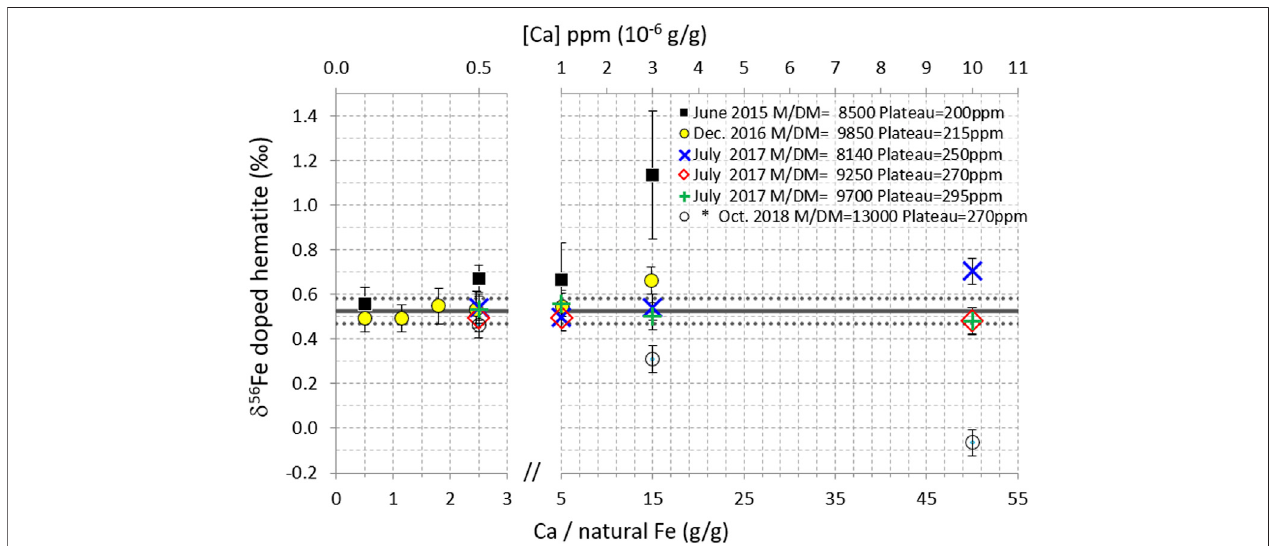
FIGURE 5 | δ 56 Fe of hematite (200 ppb natural Fe) doped with variable amounts of Ca, for fi ve measurement sessions on the Neptune and (*) one session on the Neptune Plus (2018). Data points are the averages of replicate measurements ( n (cid:1) 2 – 5), except for 2017 data (no replicate). Error bars are 2 standard deviations of the replicate measurements for the 2015 – 16 data and the long-term internal precision (2SD) of the instrument (0.06 ‰ ) for the 2017 data (no replicate) and for the 2018 Neptune Plus data (2SD of replicates being smaller than long term internal precision). The horizontal black lines show the δ 56 Fe of pure (un-doped) hematite measured during the same analytical sessions; mean value (solid line) ± 2 standard deviations (dotted